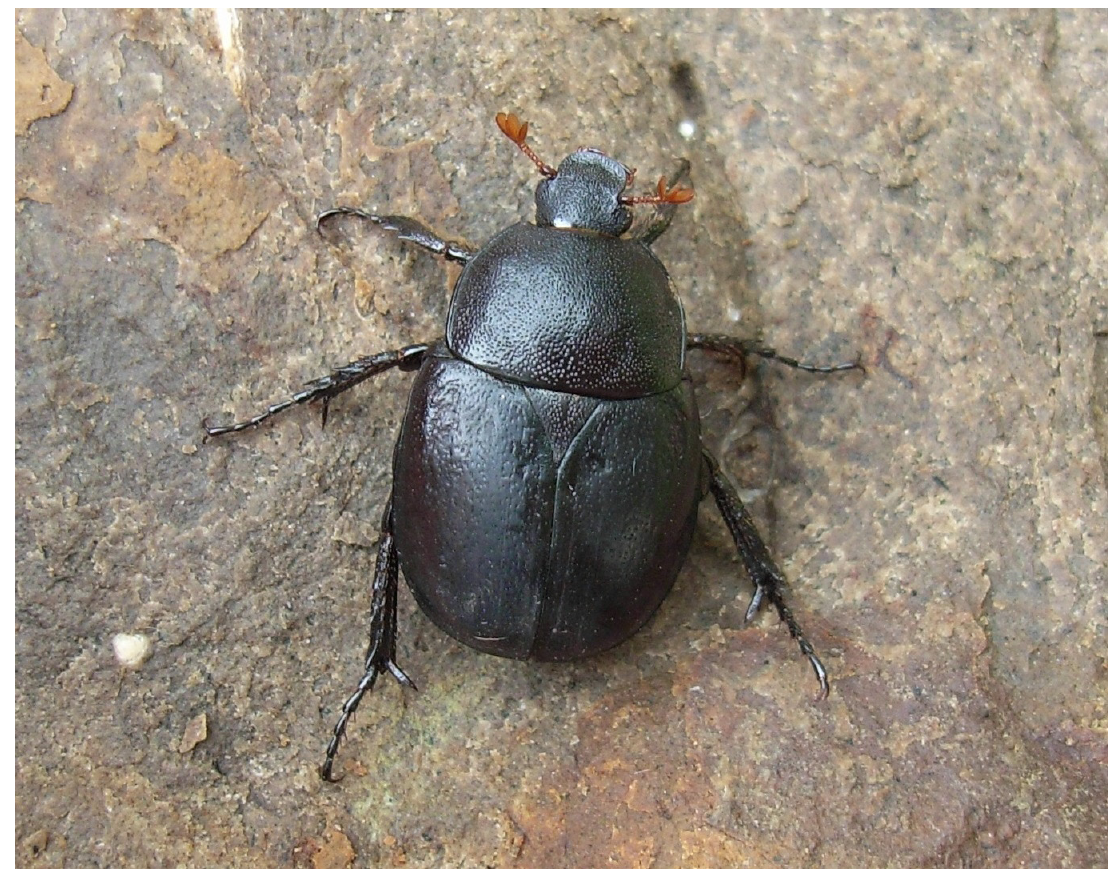
Fig. 5. Neoclita pringlei gen. et sp. nov., ♀, specimen in its natural habitat (photo: Lynette Clennell, Matatiele, 6